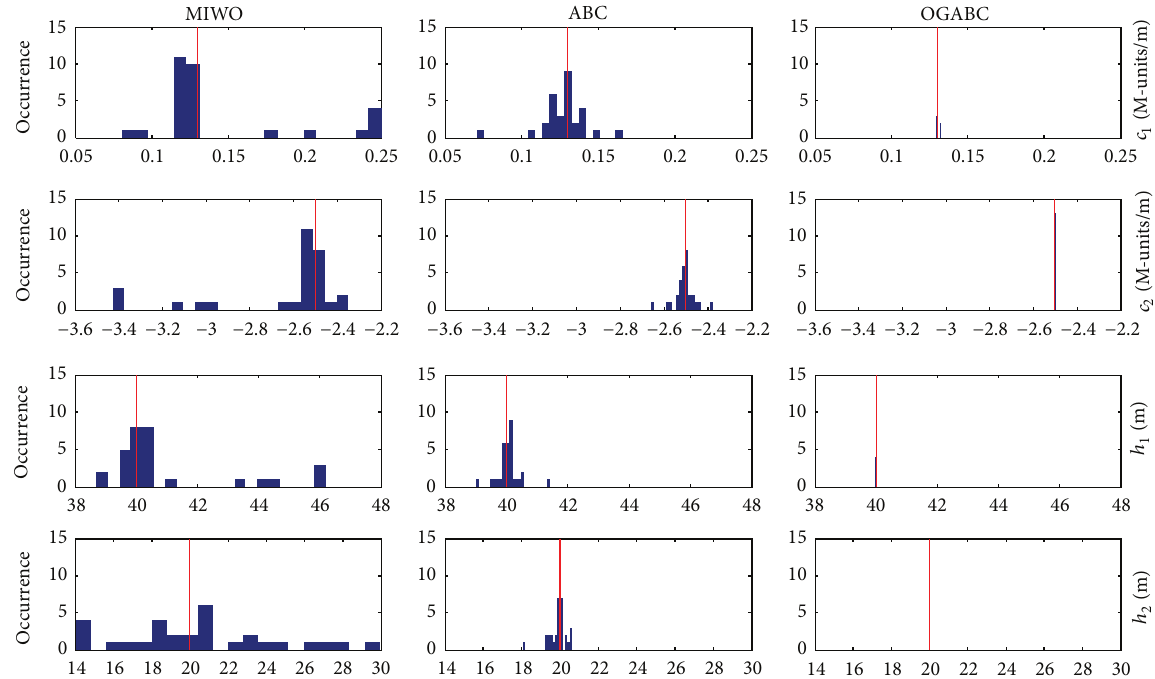
Figure 2: The comparison of the histograms of the inversion results for different algorithms with the noise level of 0dB.